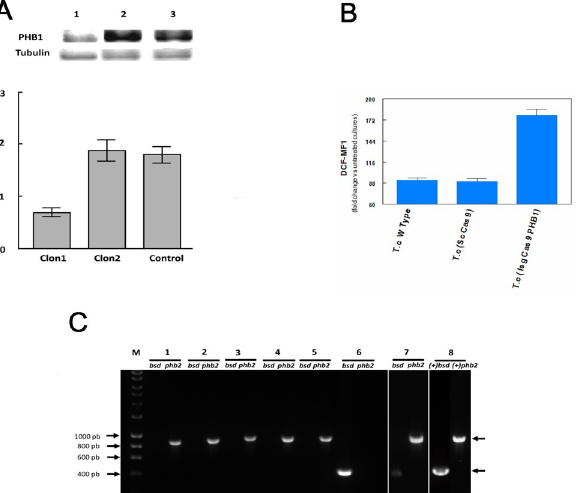
Fig 11. CRISPR/Cas9 disruption. (A) Relative expression of PHB1 in two different clones of epimastigotes of T . cruzi (1sgCas9PHB1), compared to the tubulin control. The relative expression calculations were performed using the area and intensity of the bands obtained (Quantiscan V.1.25) by Western blots. 1,2: different clones of T . cruzi (1sgCas9PHB1); 3: T . cruzi (ScCas9) (control). (B) Flow cytometry analysis of the parasites T . cruzi (1sgCas9PHB1) with a decreased PHB1 expression and the control T . cruzi (ScCas9) strain. I: measurements of DCF for the treated with H 2 O 2 and untreated samples for each cell line. The Fisher LSD test was employed to access the possible statistical differences ( p < 0.05). (C) 1% Agarose gel showing the amplification product obtained after the replacement of the phb2 gene and the incorporation of the linear fragment FRL2. M: molecular weight marker HyperLadder I (Bioline), 1–7: different clones obtained after the amplification of the phb2 and blasticidine bsd genes; 8: PCR positive